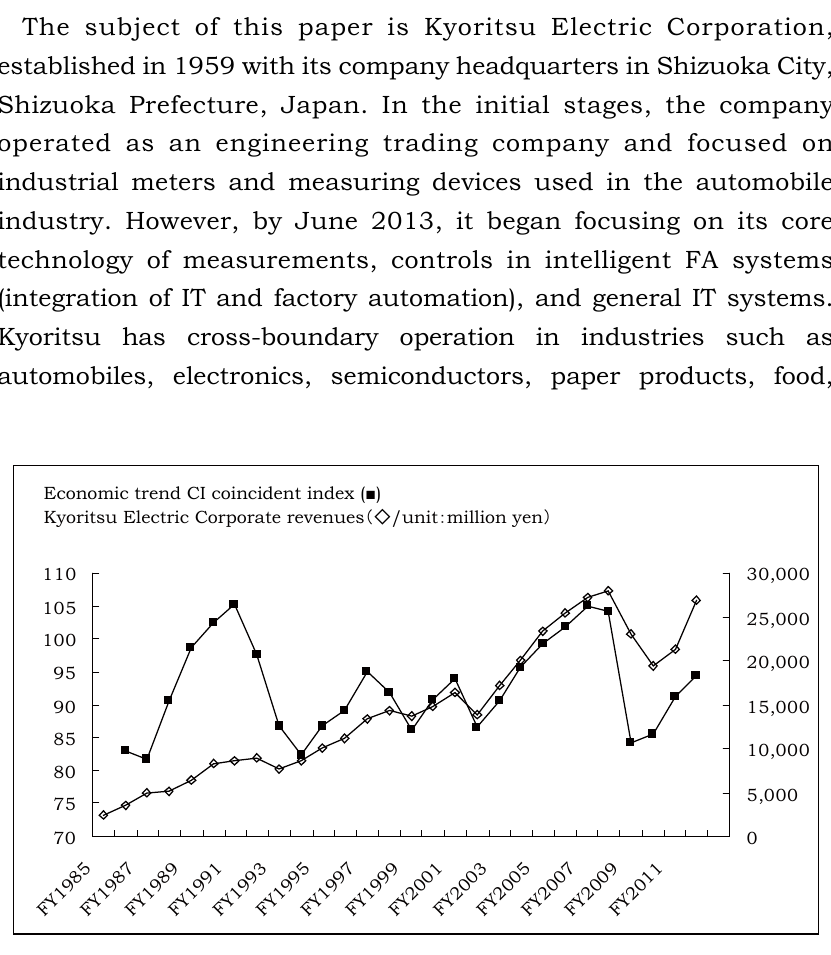
Figure 2. Comparison of fluctuations in economic trend CI coincident index and Kyoritsu Electric Corporate revenues Sources: Economic and Social Research Institute, Cabinet Office Business Statistics Section, Indicators of Economic Trends ; Kyoritsu Electric Corporation, General Tax Revenue